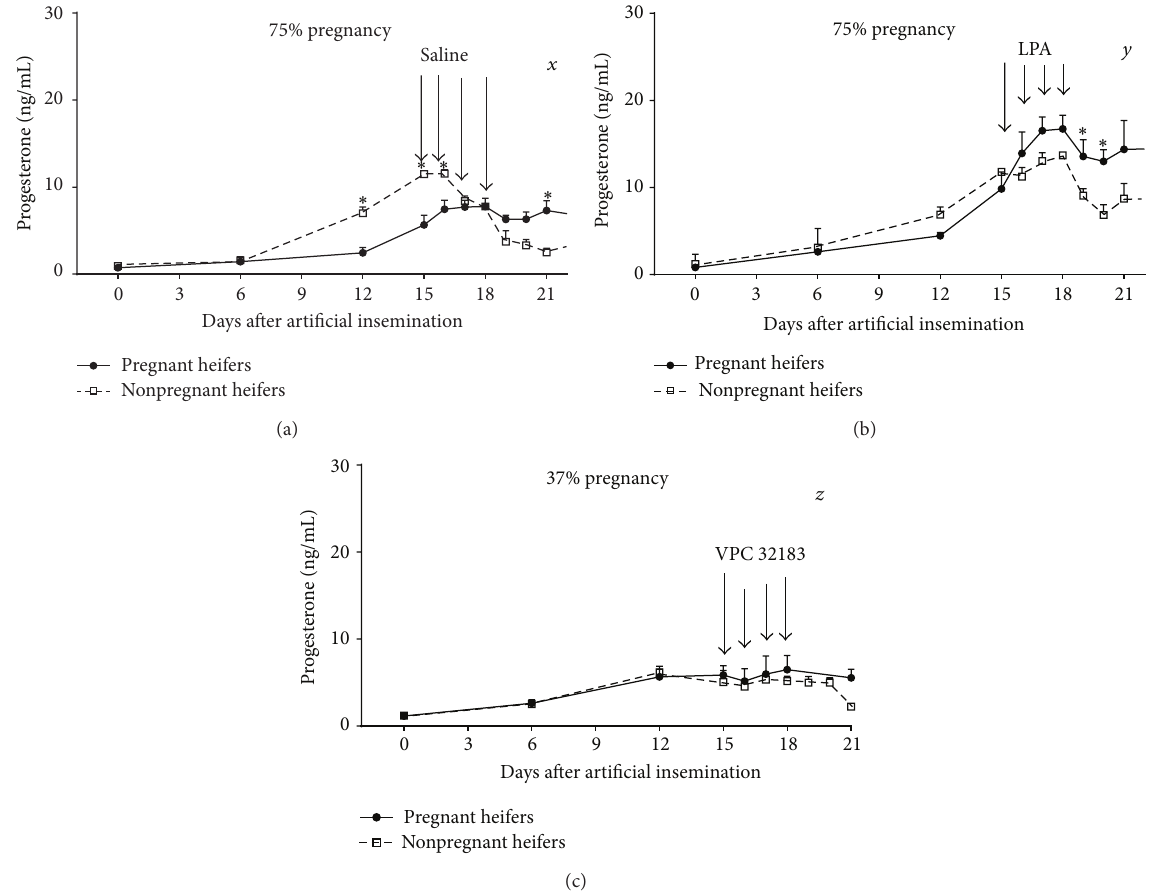
Figure 3: Concentrations of progesterone in peripheral blood plasma of pregnant (black dots) and nonpregnant (white squares) heifers infused with saline (a), 1mg of LPA (b), or 1mg of VPC32183 (c). All reagents were infused every 24 hours from day 15 to day 18 after insemination into the vagina . Different letters in the top right corner indicate significant differences ( 𝑃 < 0.05 ) between treated groups ( 𝑛 = 8 for each group of heifers). (Adapted from